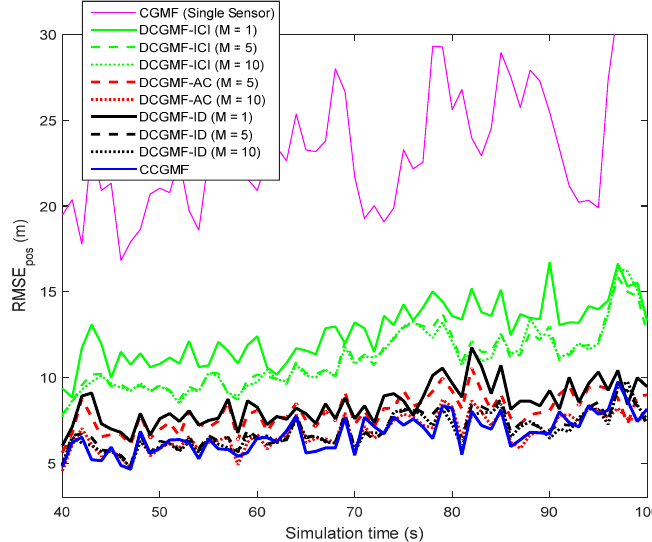
Figure 3. Root mean square errors (RMSEs) of the position estimation.